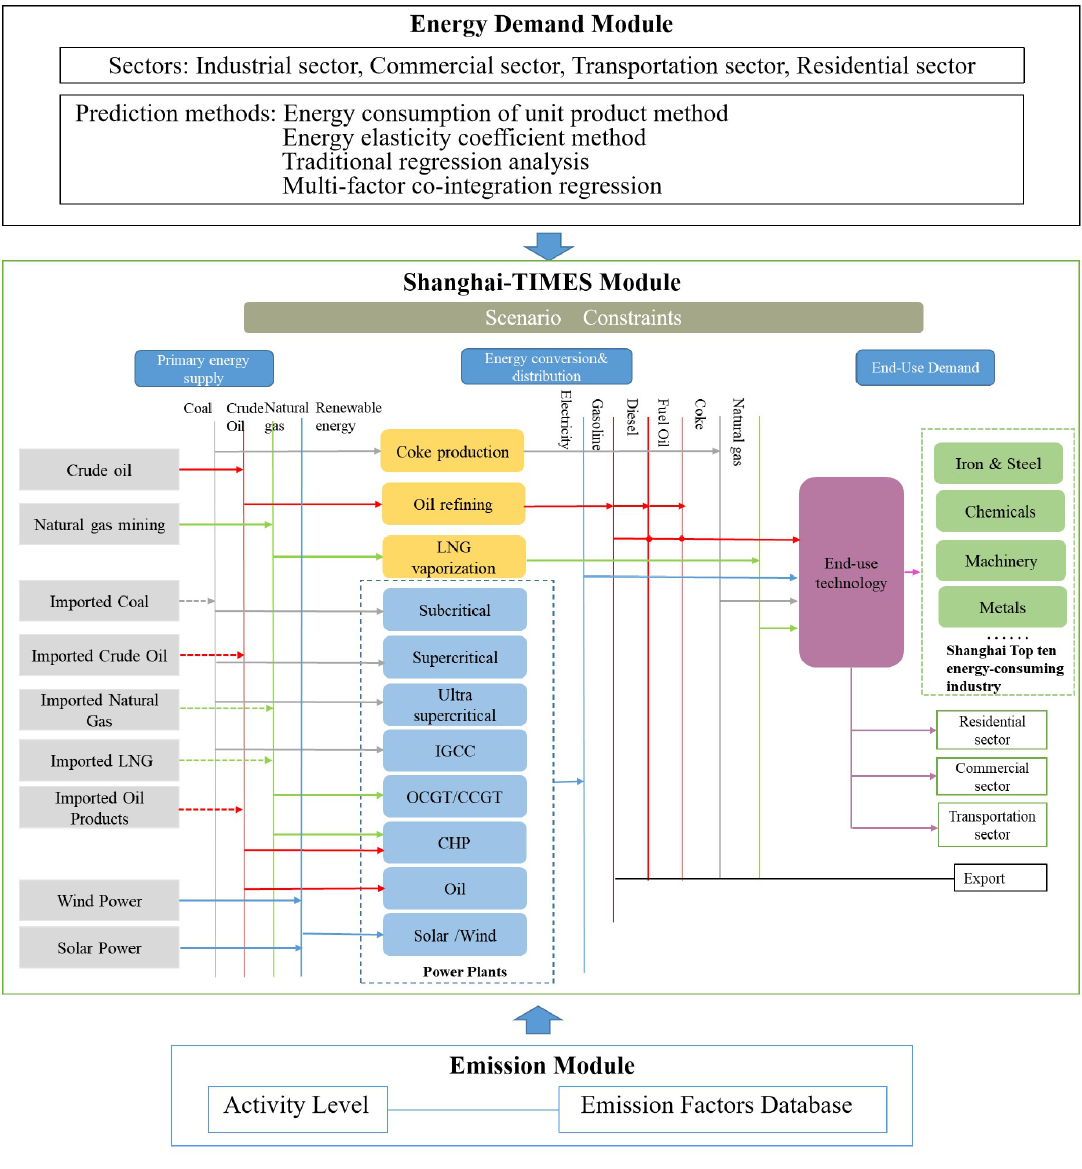
Figure 3. The framework of the Regional Energy–Environment System Optimization (REESO) model.